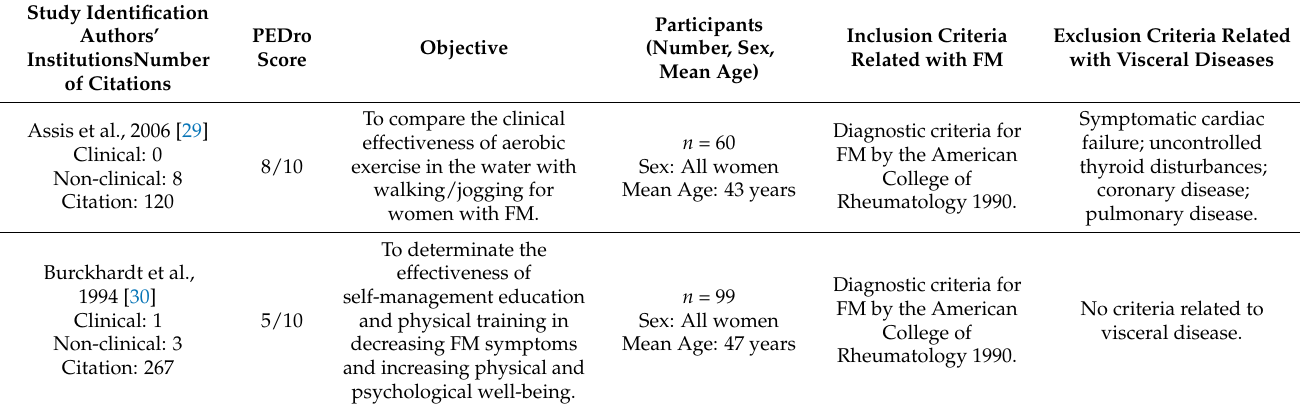
Table 1. Clinical trials evaluating the effects of physical therapy in FM fulfilling the most-cited criterion only ( n = 12). Study Identification